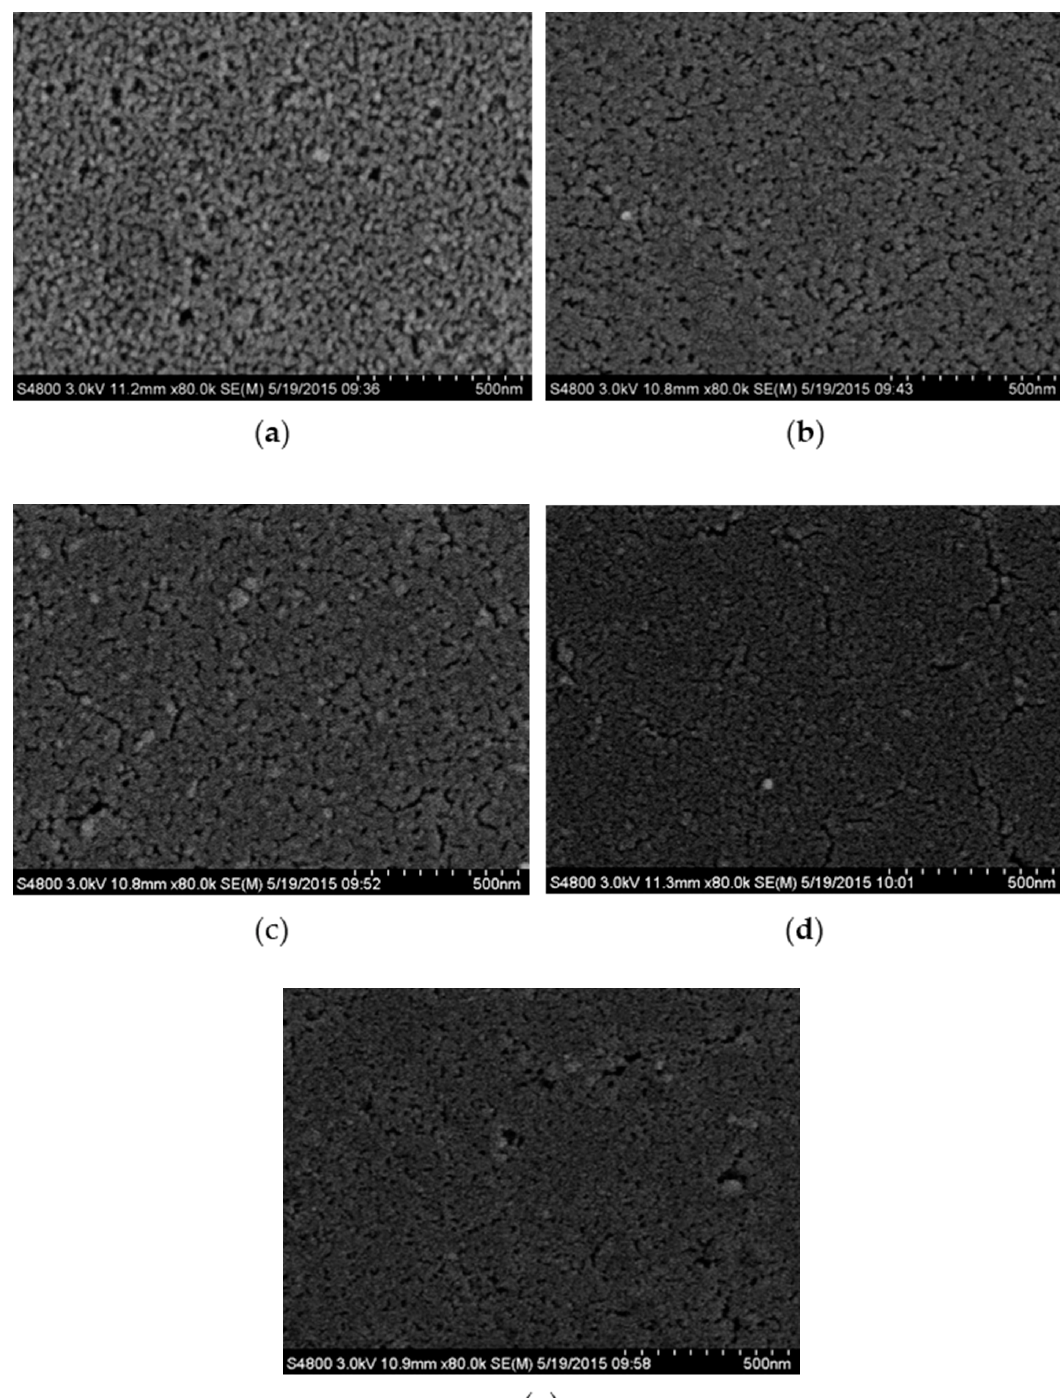
Figure 1. SEM photographs of different ZnO films (( a ) ZnO, ( b ) Al doped, ( c ) Codoped (Al:Fe = 1)).